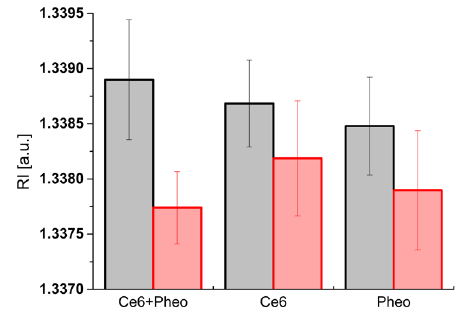
Figure 6. Column plot with error bar (standard deviation) showing the average RI values of cells before irradiation (black column) and 24 h after irradiation (red column).